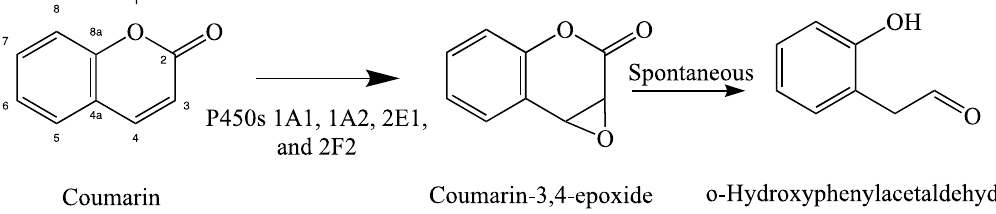
Figure 4. Coumarin metabolism leading to toxicity in rodents.